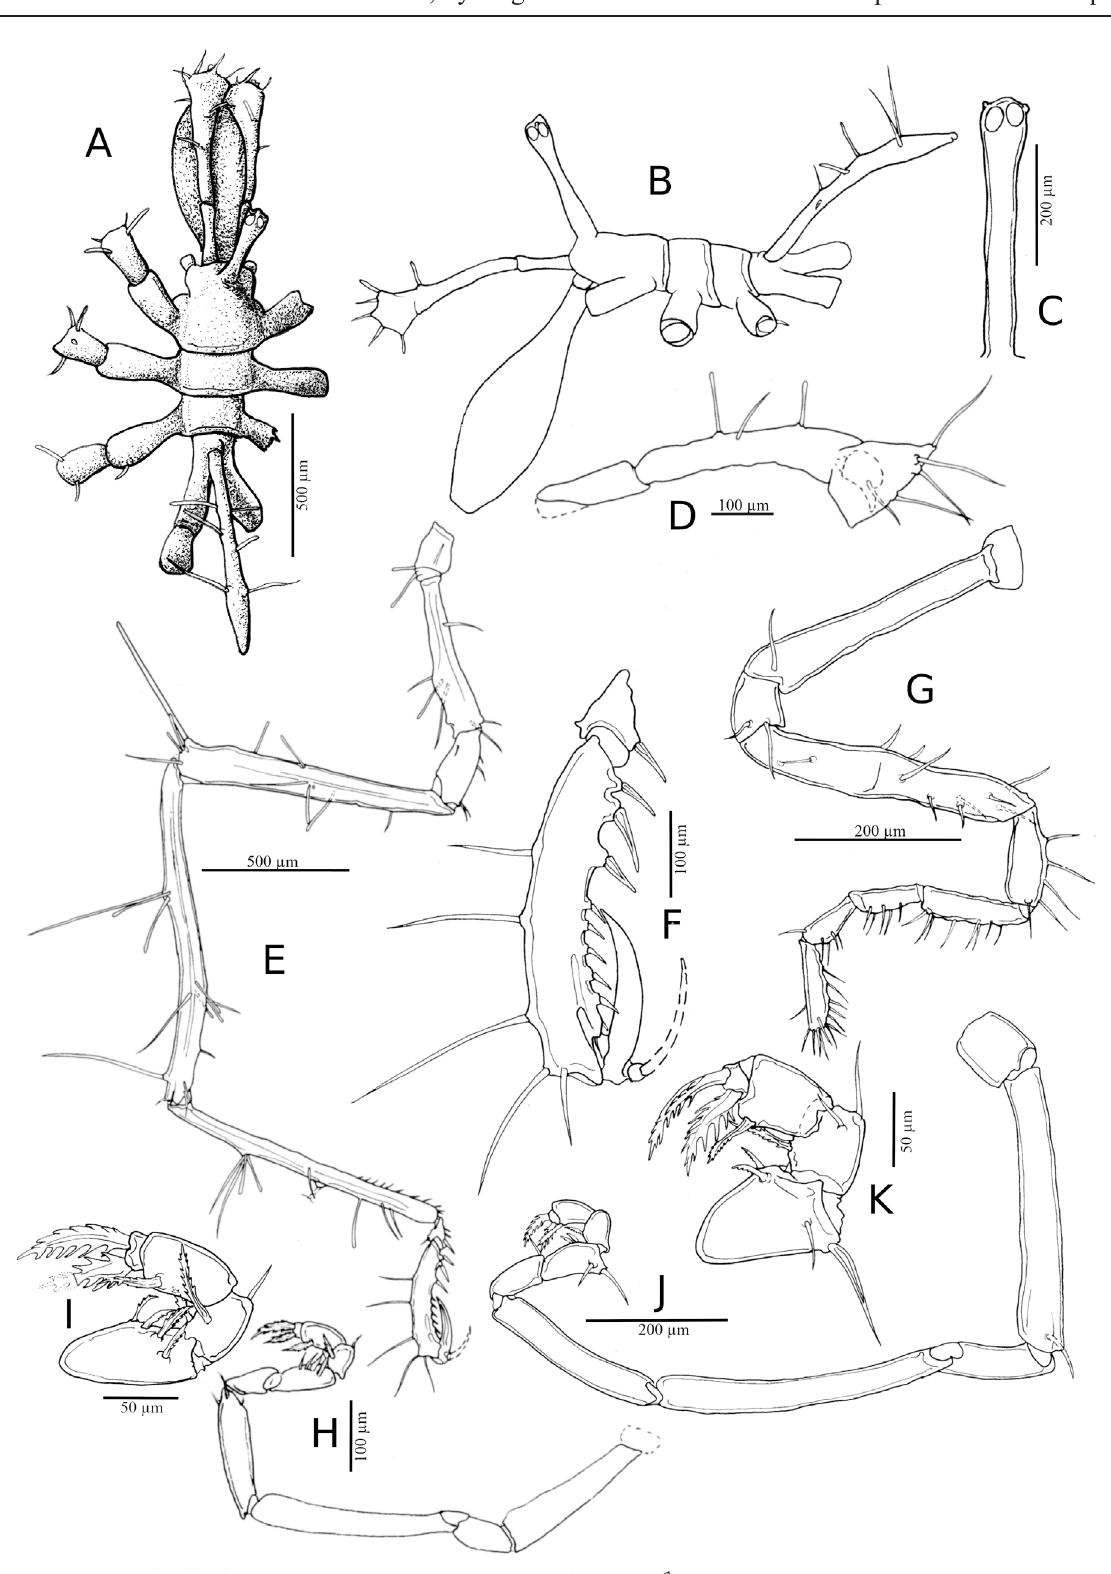
Fig. 3. Ammothella krappi sp. nov. A–G, J–K . Holotype, ♂, MNHN-IU-2016-1132. H–I . Paratype, ♀, MNHN-IU-2016-1113. A . Body, dorsal view. B . Body, lateral view (same scale as A). C . Ocular tubercle, frontal view. D . Chelifore. E . Third leg. F . Tarsus and propodus of third leg. G . Palp. H . Oviger. I . Oviger strigilis. J . Oviger. K . Oviger